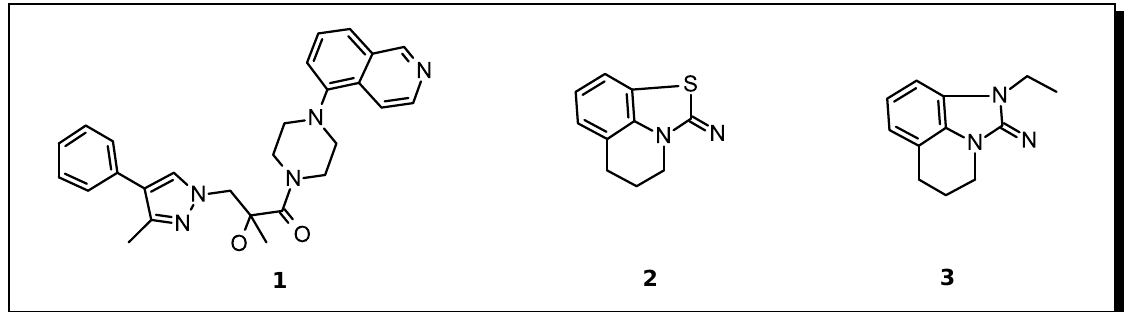
Figure 2. HTS hits identified from Sanofi compound collection.